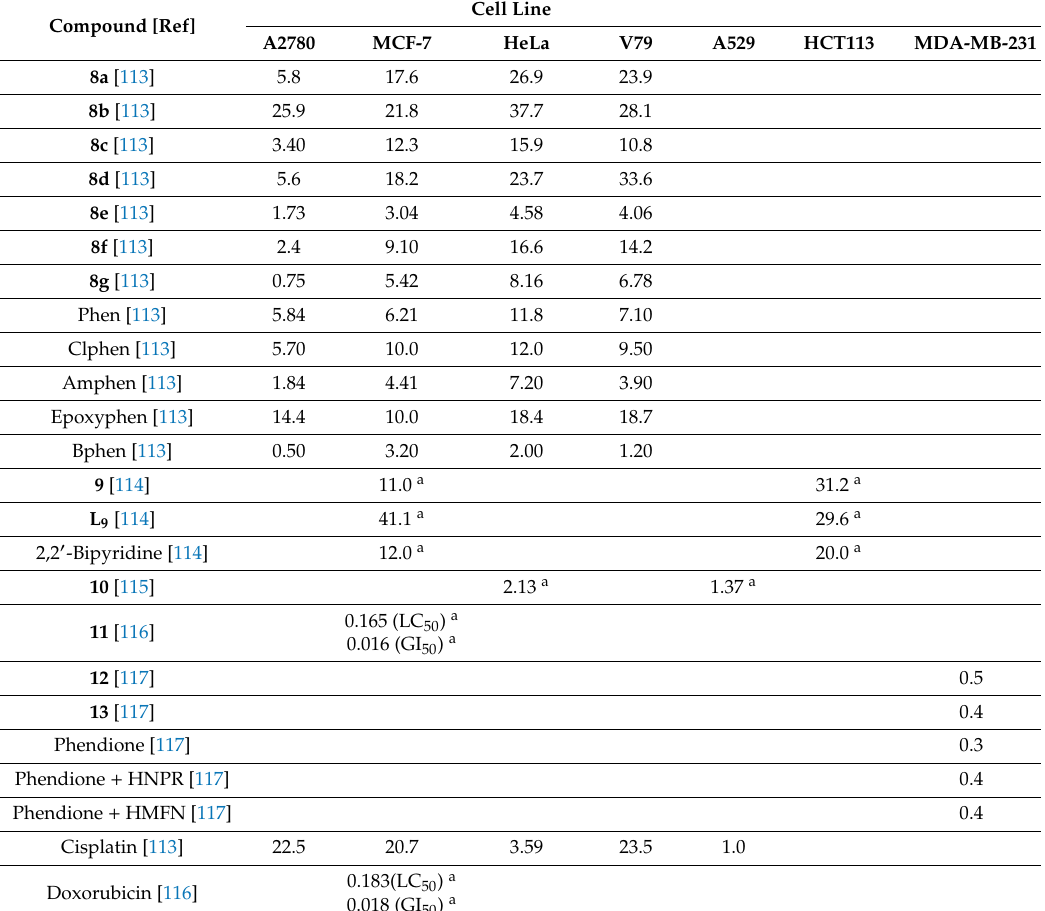
Figure 5. Structure of the zinc complexes 8a – g . Table 3. IC 50 values ( µ M) for zinc complexes 8 – 13 , ligands and the reference compounds cisplatin and doxorubicin against di ff erent tumor and normal (V79) cell lines after an incubation time of 48